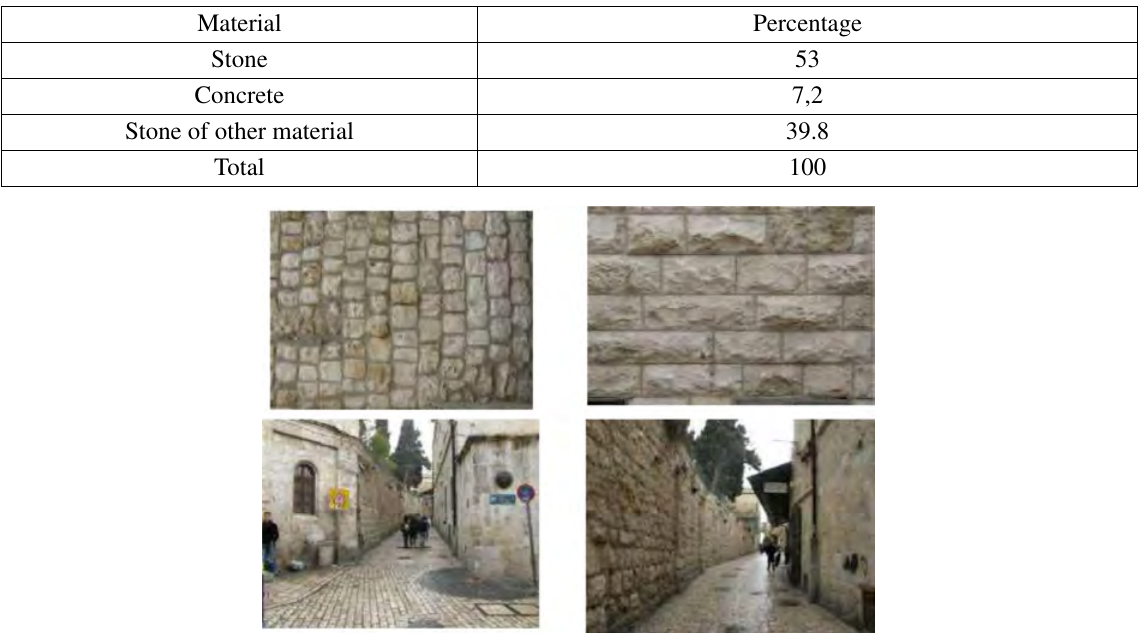
Table 1. Building material in housing in the study area